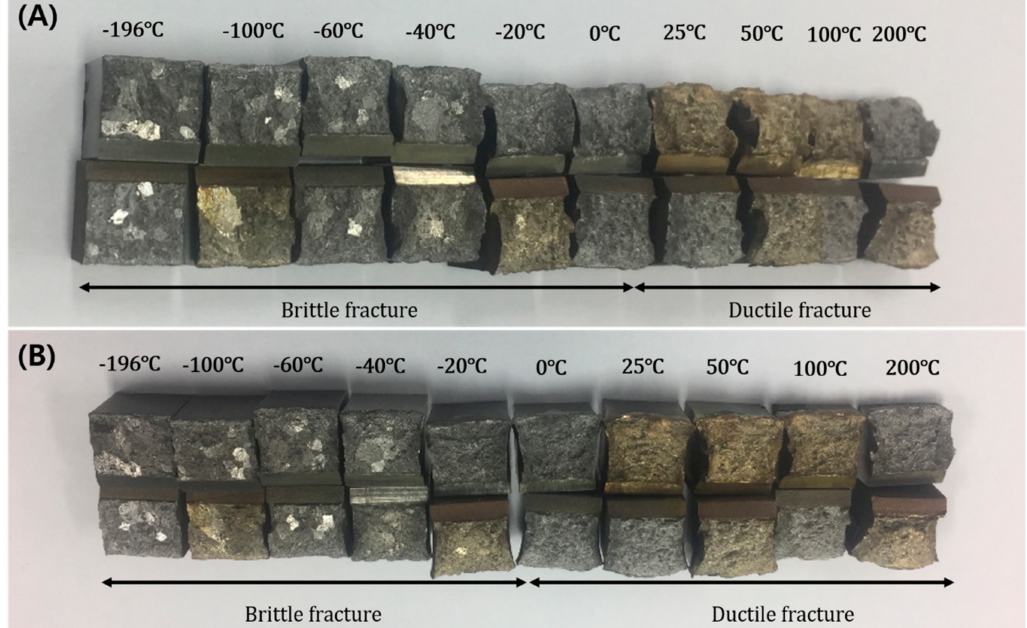
Figure 6. Fracture specimens after Charpy V-notch tests at various temperatures from − 196 ◦ C to 200 ◦ C for ( A ) BDSS and ( B )